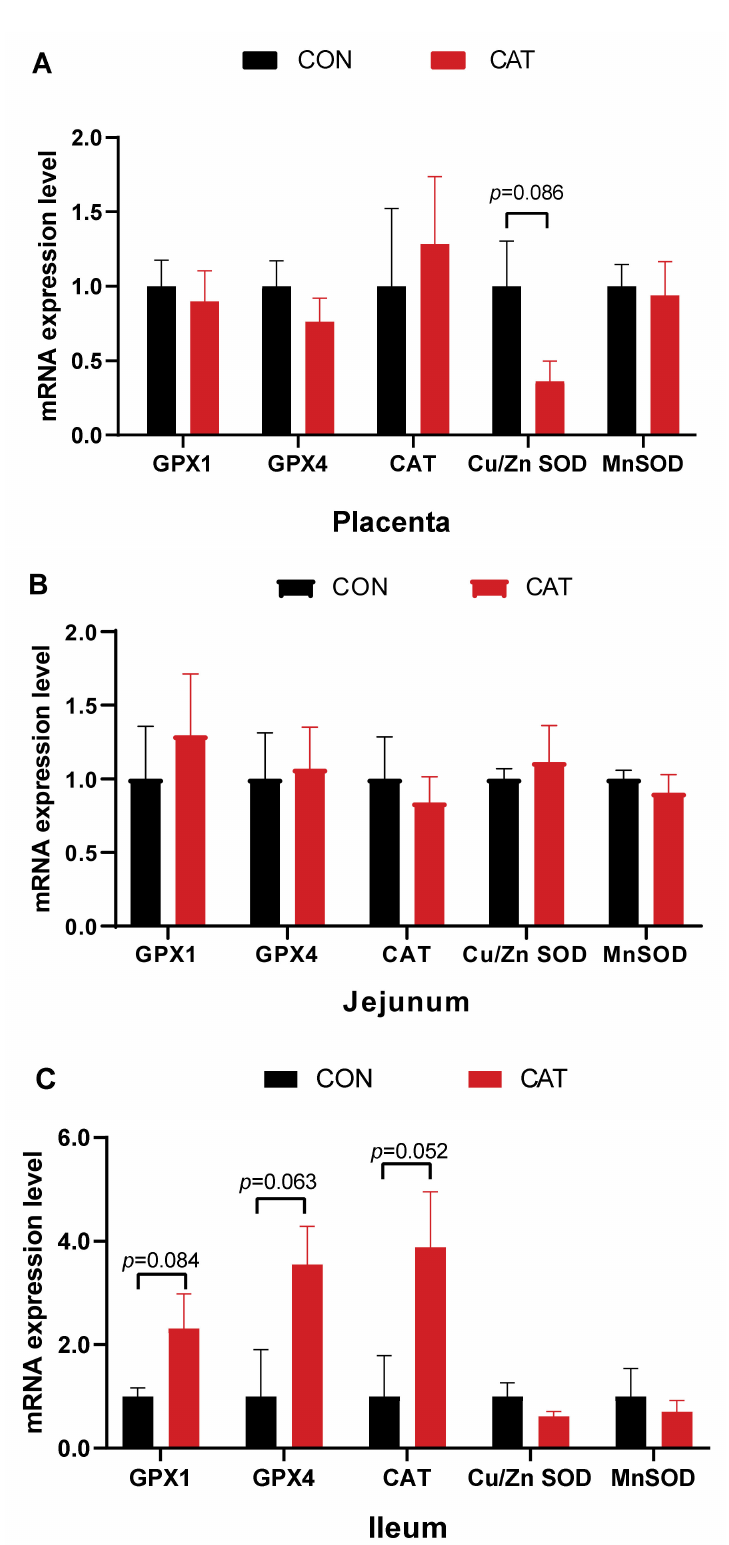
Figure 3. The effects of maternal CAT supplementation on the mRNA expression of genes related to antioxidant function in the placenta, jejunum, and ileum. ( A ): mRNA expression level in the placenta; ( B ): mRNA expression level in the jejunum; ( C ): mRNA expression level in the ileum. Data are presented as mean ± SEM, n = 8. Statistical significance was set at p < 0.05 by t